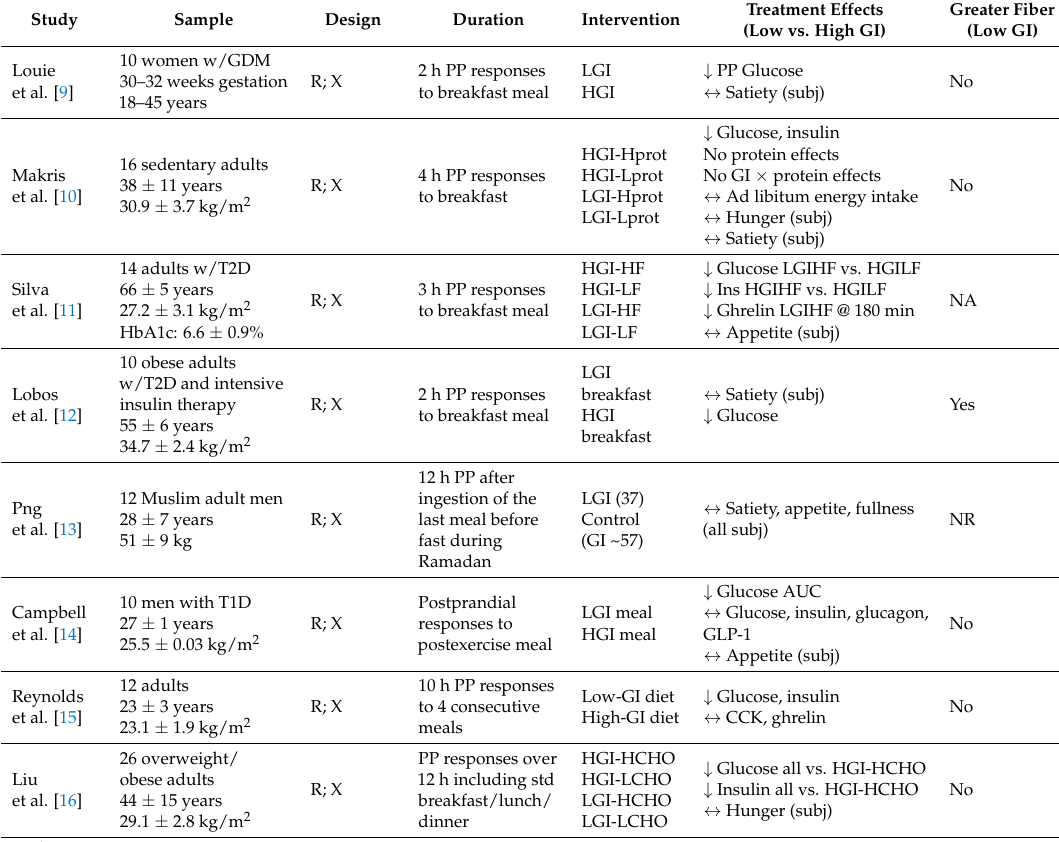
Table 1. Intervention studies assessing the acute effect of low GI foods or meals on appetite/satiety 1